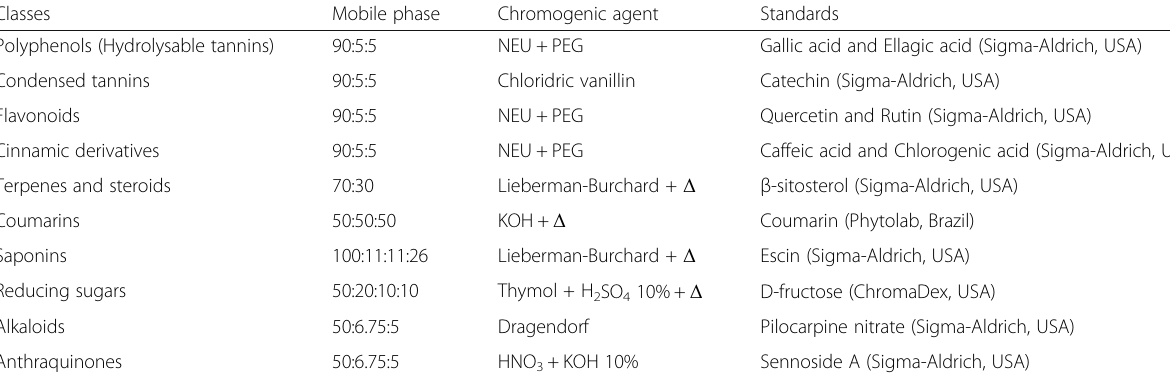
Table 1 Elution systems, chromogenic agents, and standards used in the phytochemical analysis of the hexane extract from Spondias tuberosa leaves with thin-layer chromatography